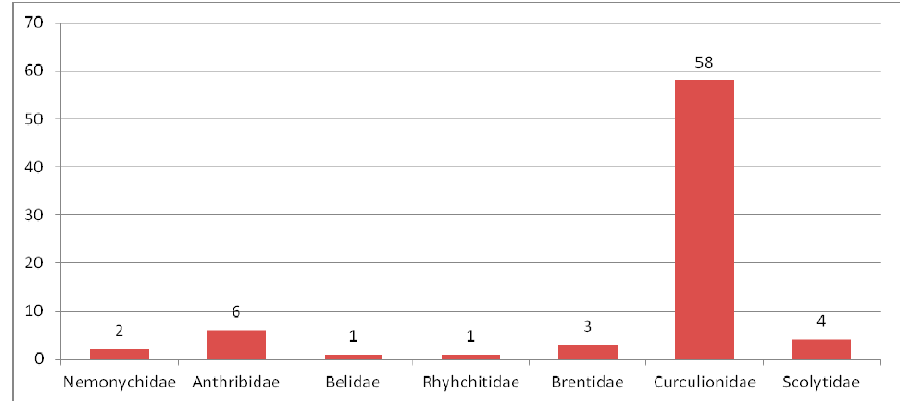
Figure 9. Lutetian Curculionoidea deposits: octagon—Roan Mountain and Green River; square—Corfe and Bournemouth; circle—Messel and Eckfelder Maar, rhombus—Geiseltal.